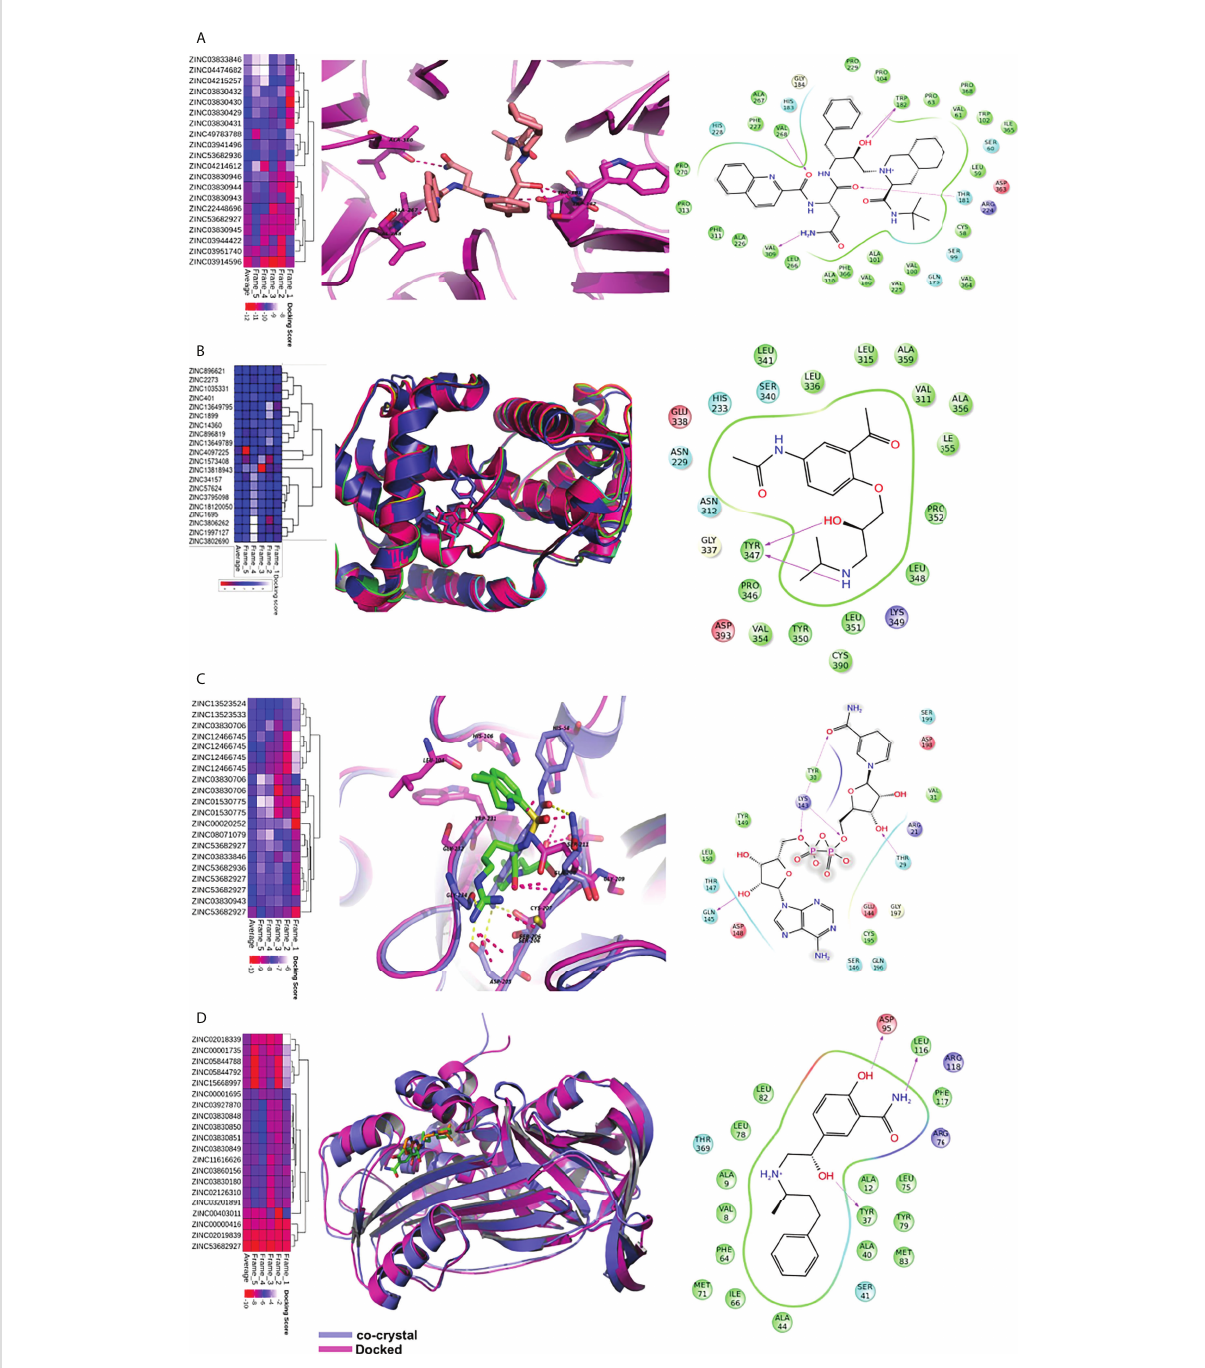
FIGURE 7 Virtual screening of FDA approved drugs against identi fi ed proteins. Top scoring 20 molecules for each of the fi ve proteins are shown in heatmap ( fi gures A – D ). The fi rst column depicts the heatmap of docking scores in fi ve MD frames. The average docking score is also depicted for better understanding. In the second column, proteins are shown in cartoon while the ligands are shown in sticks. The dotted lines depict hydrogen bonds. The third column depicts the interaction map of the ligand receptor interactions. The pink arrows show hydrogen bonds. The arrowhead depicts the HB-acceptor molecule. Pi-pi stacking interactions are depicted by green line. (A) The docking of saquinavir with BOP1. It makes hydrogen bonding interactions with backbone of TRP-182, VAL-268, VAL-309, and sidechain of THR-181. (B) The binding of molecules in CCNA2. The diacetolol is shown in blue sticks. The ligand makes hydrogen bonds with Tyr347 (C) The binding of ligands in PLAU. NADH is shown in binding site of PLAU. It makes hydrogen bonding interactions with THR30, TYR31, LYS154, and SER157. (D) The binding of ligands in SERPINE1, and docked molecule labetalol. The drug forms hydrogen bonds with sidechain of ASP-95,